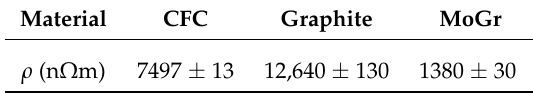
Figure 13. Measured resistivity for CFC, graphite and MoGr samples as a function of frequency (dotted lines) together with sample thickness normalized to the material penetration depth (dashed lines). Table 6. In-plane electrical resistivity of CFC, graphite and MoGr measured with the